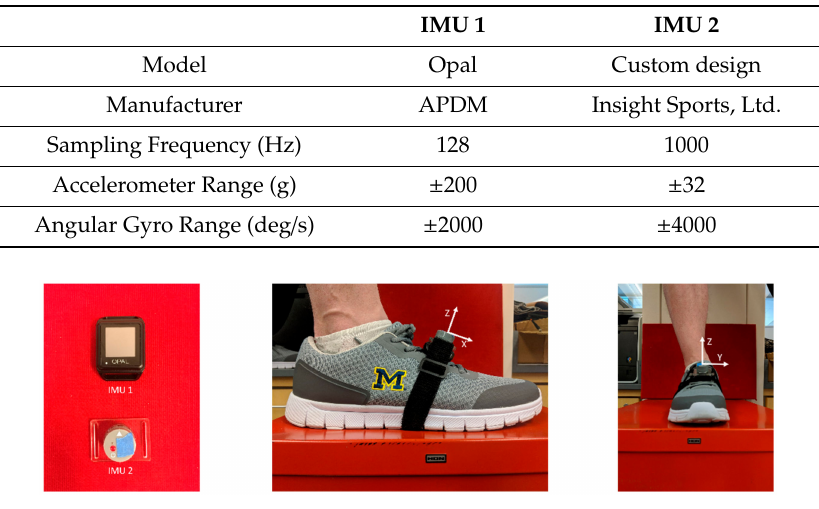
Figure 1. Two inertial measurement unit (IMU) designs and the means of attachment to a foot. ( a ) IMU 1 (Opal, APDM, left) and IMU 2 (custom design, Insight Sports, Ltd., right); ( b and c ) Side and front views of attachment of both IMUs to the instep via a Velcro strap. Sensor axes are denoted by X, Y, and Z (X and Z largely lie in foot sagittal plane and Y largely points to subject’s left). Note that these axes are illustrated to aid interpretation of the raw data signals presented in Figures 4 and 8, and that the zero-velocity update (ZUPT) method herein does not require specific sensor alignment to anatomical